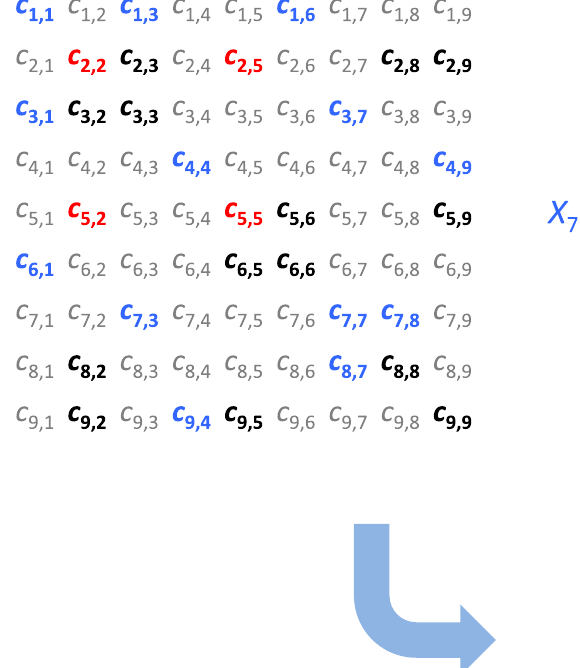
, X , (red nodes/edge). The neighborhood of this pair is the 2 5